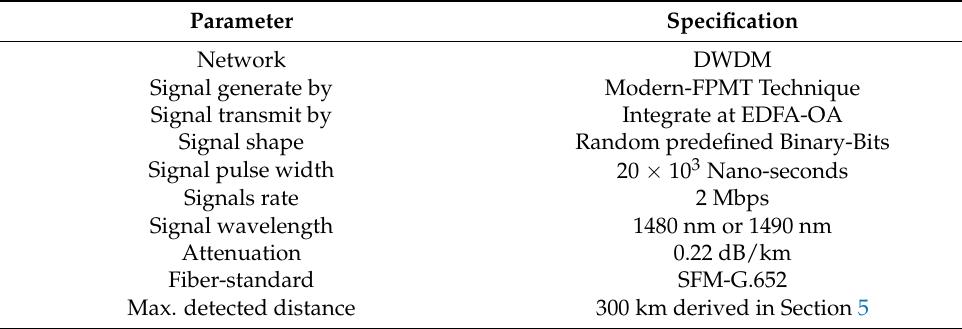
Table 1. The test signals specification.